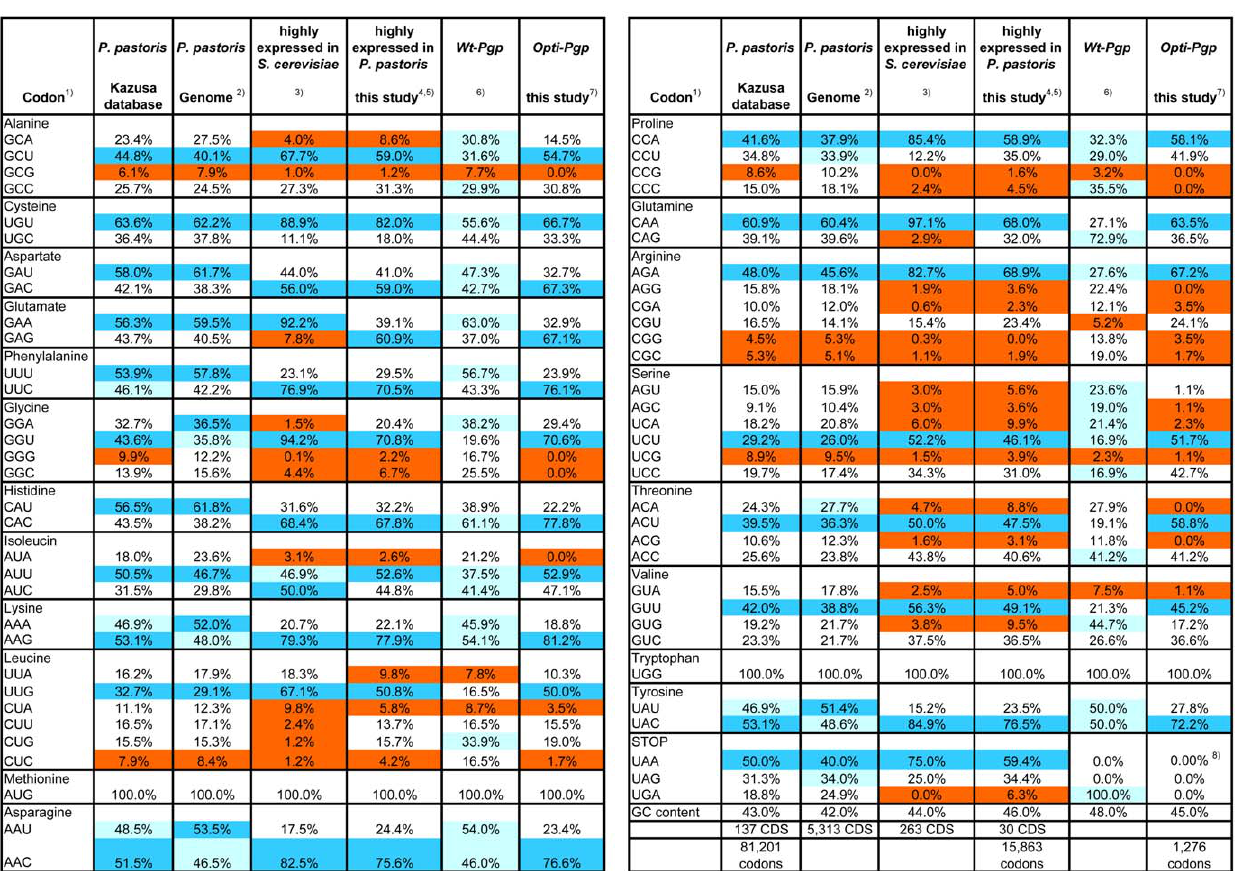
2 70 u C. Mass populations were grown overnight in uracil deficient medium to an OD 600 of 1 for protein expression and functional analyses. For Western blot analysis, microsomal membranes were processed from 10 ml cultures [13] and the protein concentrations determined with the Bradford protein assay (BioRad) using BSA as a standard. Equal amounts of membrane protein (15 m g) were resolved on SDS-gels, transferred to a nitrocellulose membrane and stained with Ponceau S (total protein loading control). After washing, the immunoblots were developed with the monoclonal